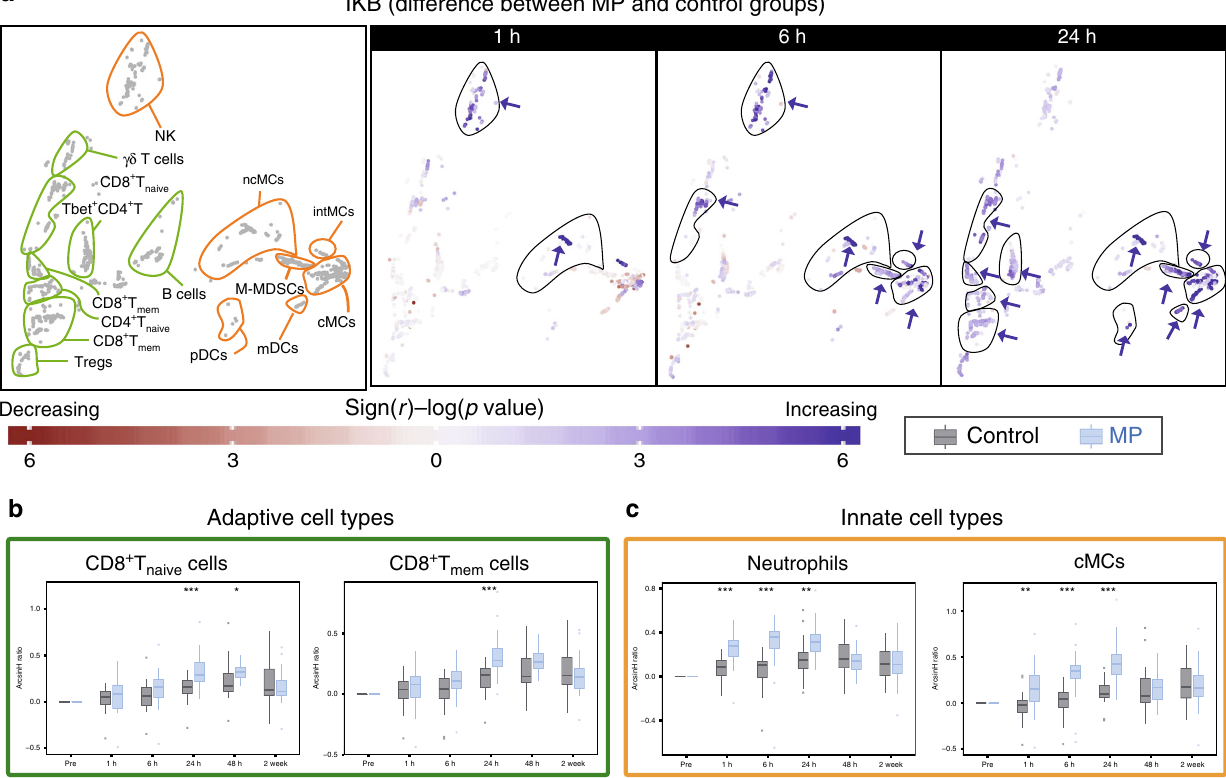
Fig. 5 Alteration of total I κ B α by MP. a Immune cell atlas depicting differences in total I κ B α (arcsinh ratio) between the control ( n = 30 patients) and MP ( n = 28 patients) group at 1, 6, and 24 h after surgery. Blue/red cluster colors indicate increased/decreased signaling in the MP group, respectively (two- sided Wilcoxon rank-sum test). MP treatment resulted in increased total I κ B α in both the adaptive (CD4 + T mem , CD4 + T naive , CD8 + T naive and CD8 + T mem , contoured in green) and the innate compartment (CD56 lo CD16 + NK cells, mDCs, cMCs, ncMCs, M-MDSCs and DCs, contoured in orange, which was most prominent at 6 and 24 h after surgery. b , c Box-plots depict total I κ B α in manually gated immune cell subsets corroborating observations contained in the immune atlas. Select immune cell subsets for which MP ’ s effect on total I κ B α was most pronounced (CD8 + T naive and CD8 + T mem , cMCs, and neutrophils) are shown. All boxplots show median values, interquartile range, and whiskers of 1.5 times interquartile range. (Two-sided Wilcoxon rank-sum test, * p < 0.01, ** p < 0.001, *** p < 0.0001). Exact p -values are available in Supplementary Table 2.